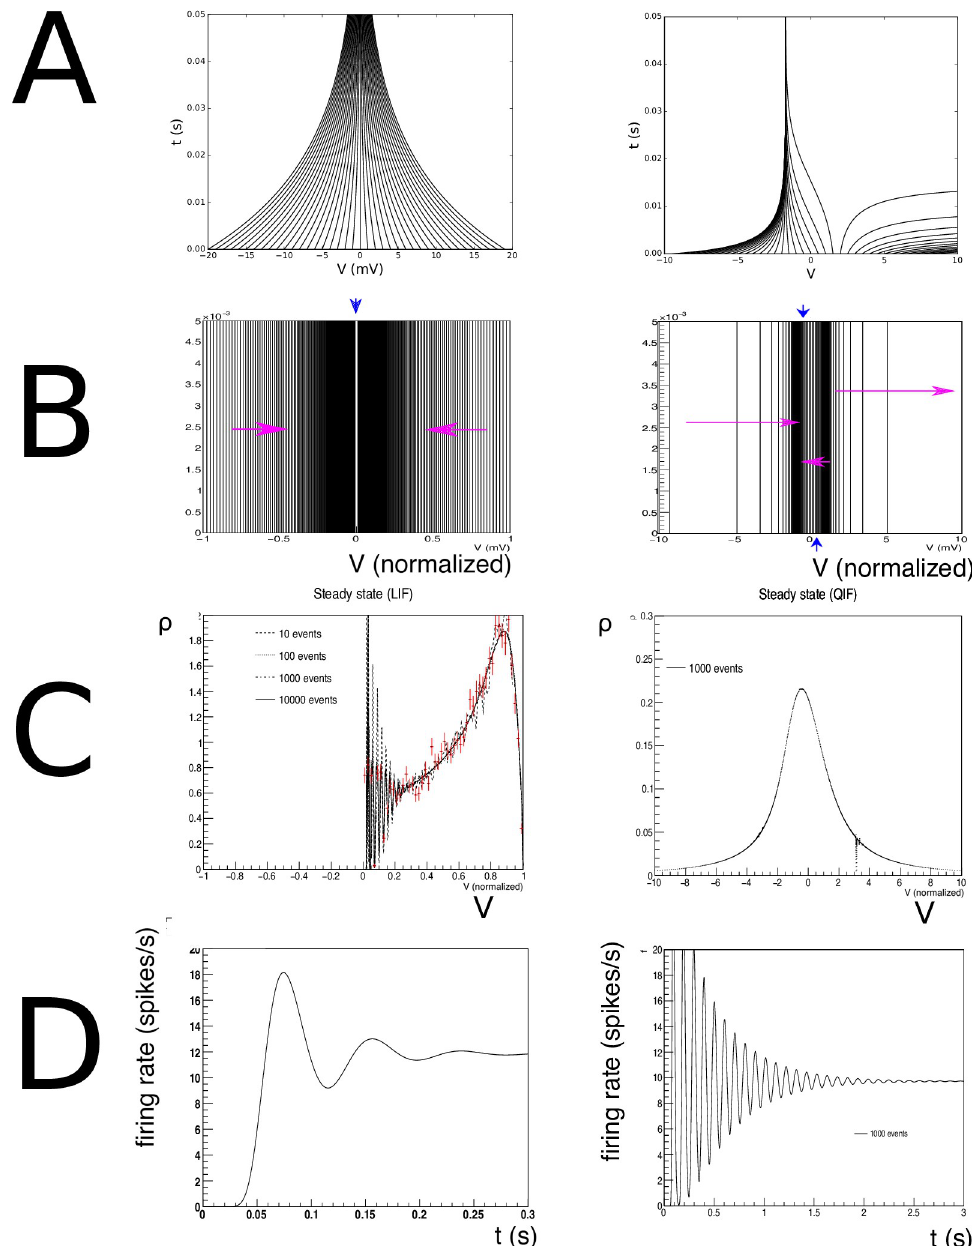
Fig 6. A: Characteristics for leaky- (left) and quadratic-integrate-and-fire (right) neurons. B: The resulting grids for both neuron types. C: Typical steady state densities, strongly influenced by the shape of the grid, and ultimately the neural dynamics. D: a typical jump response of the firing rate. For comparable output frequencies, QIF neurons “ring” for longer, which we attribute to a closer grouping of probability mass.